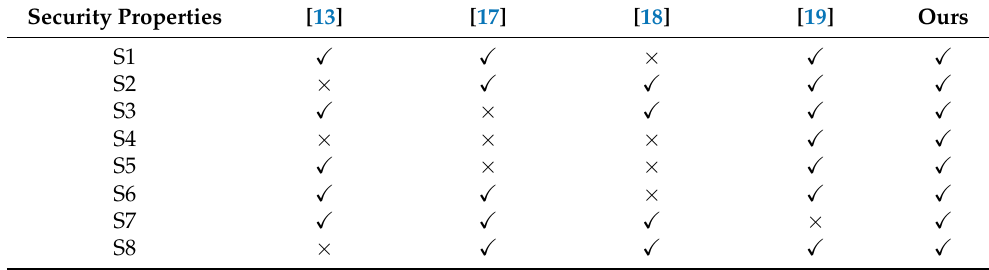
Table 3. Comparisons of security.